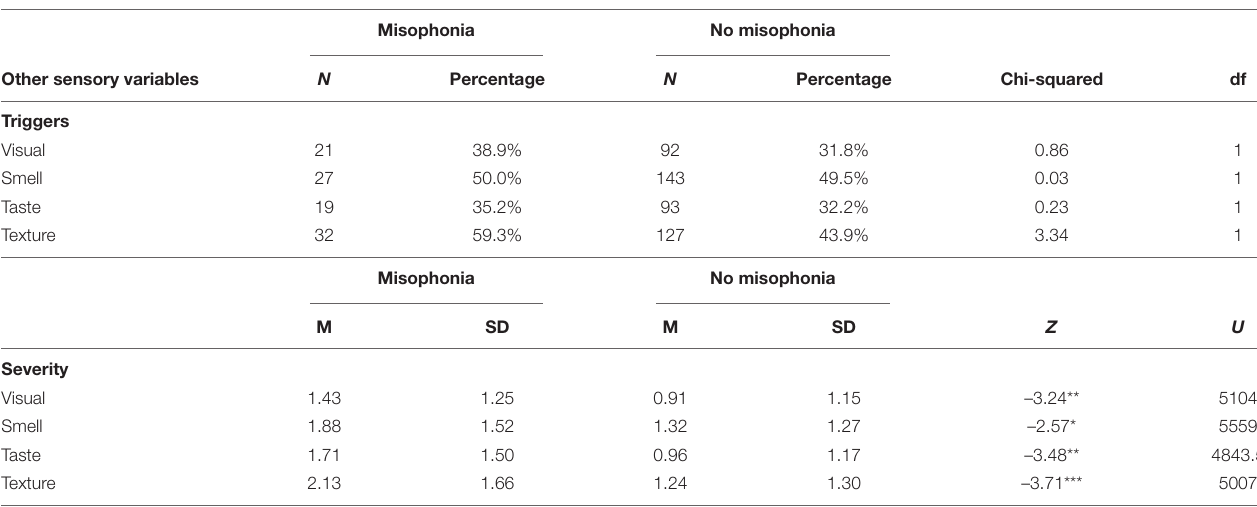
TABLE 6 | Results of independent samples t -tests comparing misophonia groups on other sensory triggers. Misophonia No